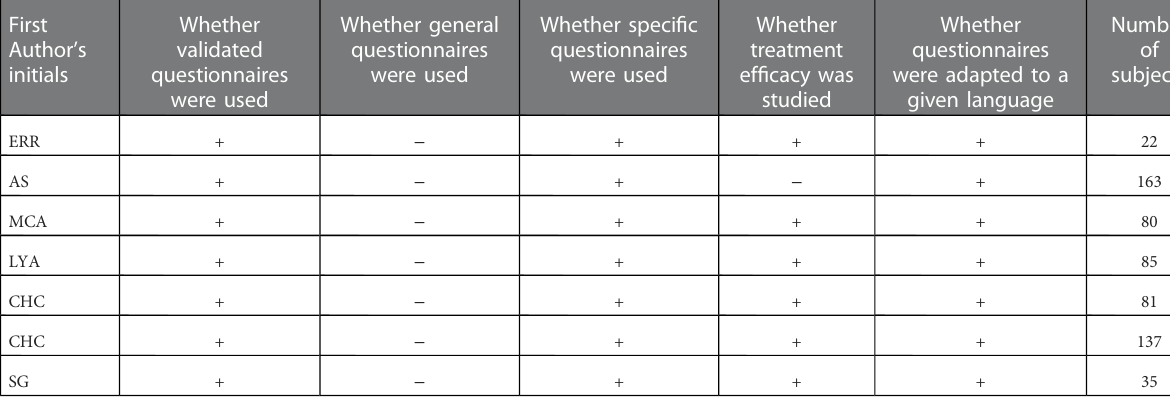
TABLE 2 Chosen HRQoL studies on chronic